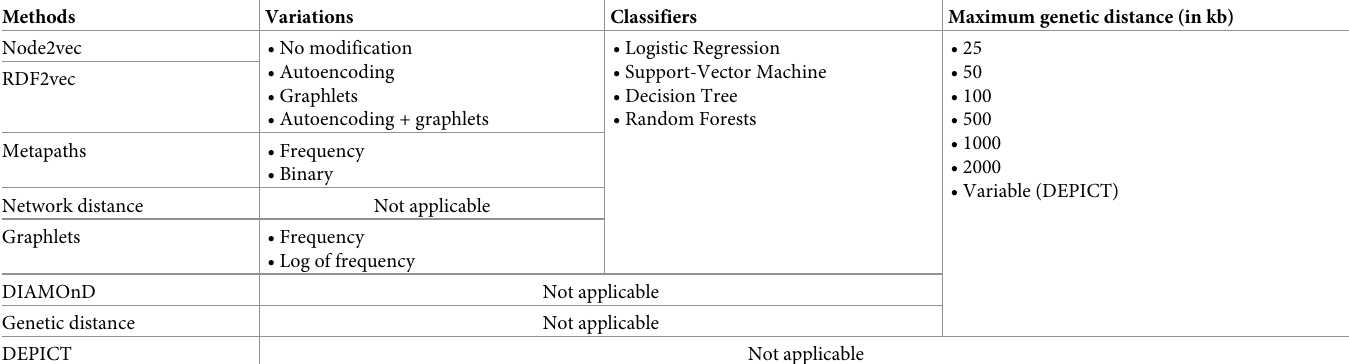
Table 2. Overview of the various methods and experimental